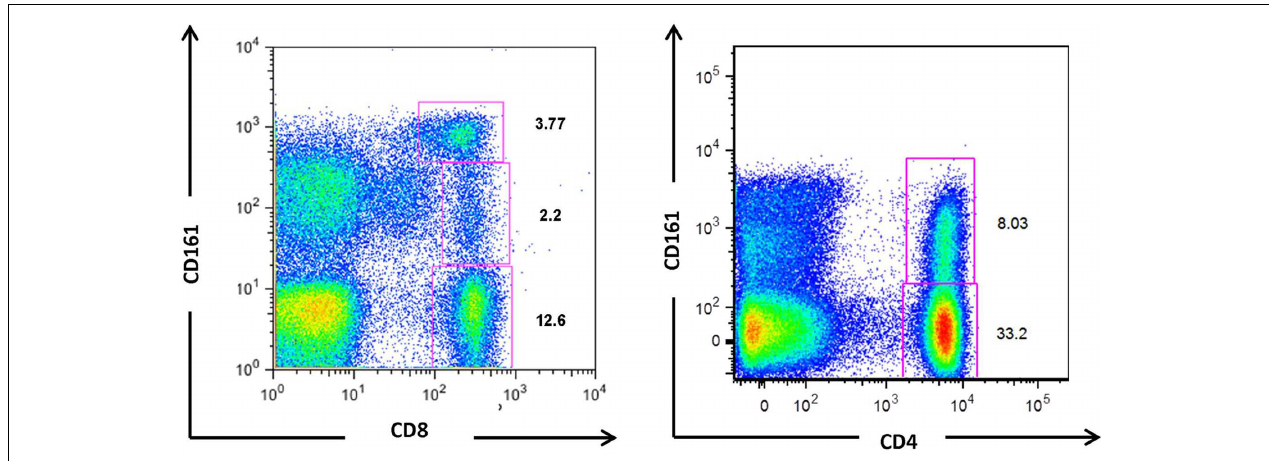
FIGURE 1 | CD161-expressing populations in CD8 + and CD4 + T cells. Flow cytometric analyses ofT cells from healthy individuals demonstrate the existence of three populations of CD8 + T cells; CD161 − , CD161 int , and CD161 high , and two CD4 + T cell populations; CD161 − and CD161 int . Some donors may display a CD161 high CD4 + population, but in the majority CD161 positive CD4 + T cells comprise a single population with intermediate expression